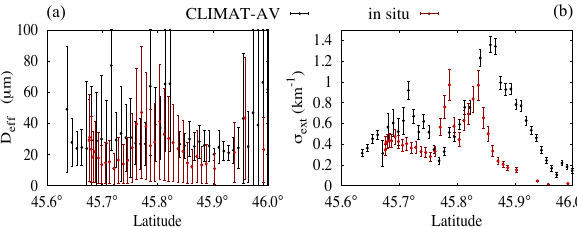
Fig. 10. Effective diameter (a) and visible coefficient (b) retrieved from the GF20 instruments (in red) and by our methodology us- ing CLIMAT-AV measurements (in black) for the 16 May 2007 leg presented in Fig. 9a.